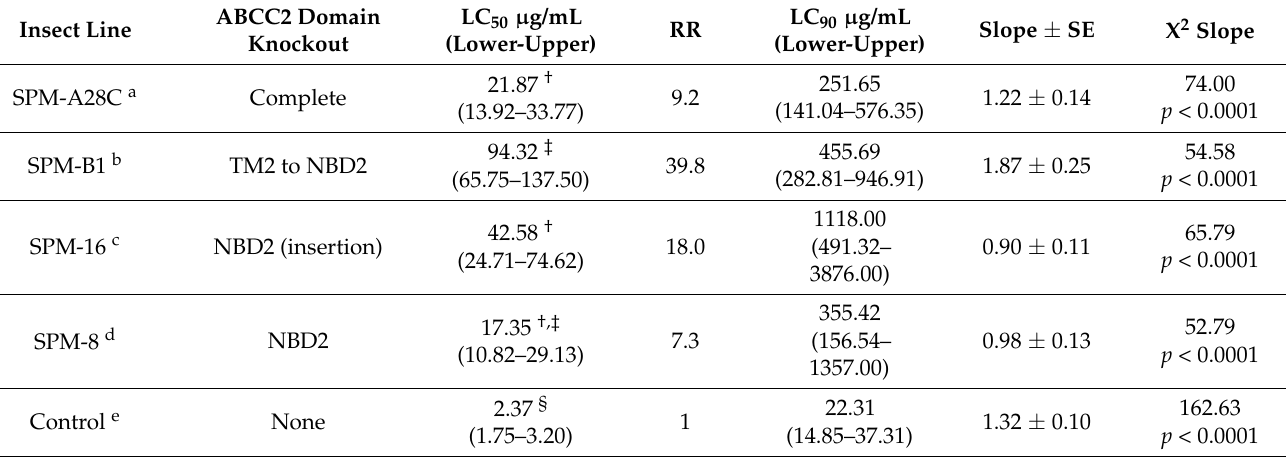
Table 3. Bioassay data for control (SIMRU) and ATP binding cassette transporter subfamily C2 (ABCC2) knockout lines of Helicoverpa zea to estimate the concentrations Cry1Ac that killed 50 and 90% larvae (LC 50 and LC 90 , respectively) and their fiducial limits (Lower-Upper). Slope of the regression line, standard error of slope, Chi-square value of the slope and the p -value are also presented. Significantly different LC 50 values (based on non-overlapping fiducial limits) are denoted by different symbols ( † , ‡ , and § ). Cry1Ac concentrations ( µ g/mL) used in bioassays: a 0, 1, 10, 50,100; b 0, 1, 10, 100, 500; c 0, 1, 10, 100, 1000; d 0, 1, 10, 100; e 0, 0.1, 1, 10, 100. RR = LC 50 ratio between edited and control